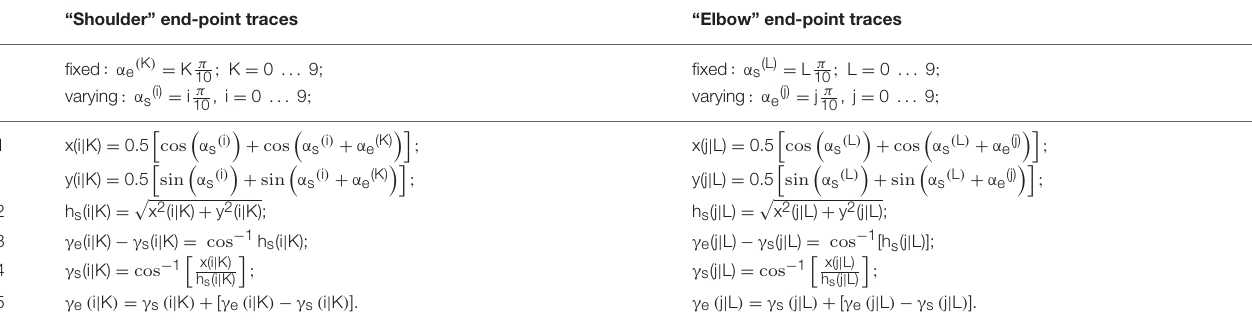
TABLE 1 | Sequences of the procedures used to determine the characteristic angles γ e and γ s in various end-point positions within the working space. “Shoulder” end-point traces “Elbow” end-point